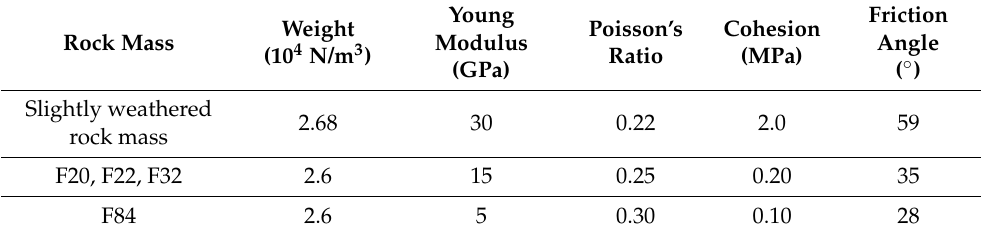
Figure 8. The spatial distribution of seven test points in 3D calculating model. Table 1. Parameters of rock mass.